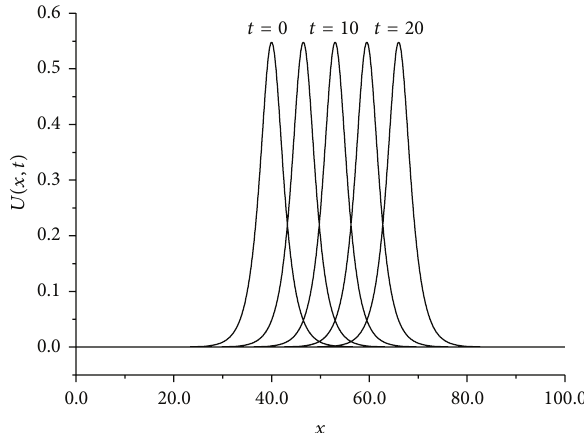
Figure 2: Single solitary wave with 𝑐 = 0.3, ℎ = 0.1, Δ𝑡 = 0.01, 0 ≤ 𝑥 ≤ 100 at times 𝑡 = 0,5, 10, 15 , and 20